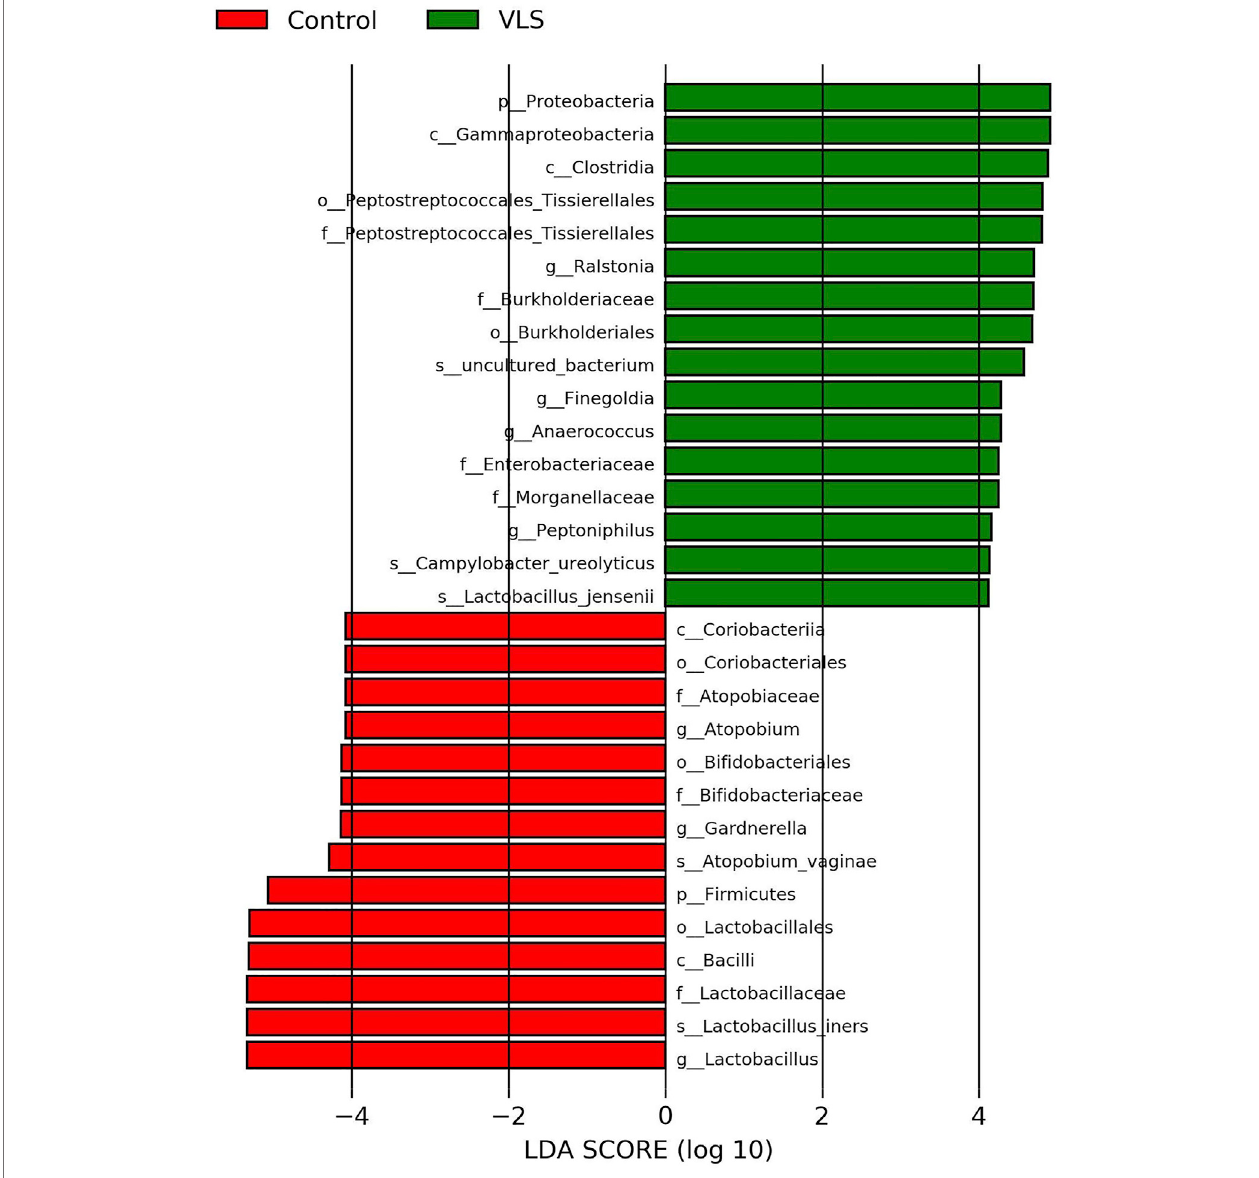
Frontiers in Cell and Developmental Biology |